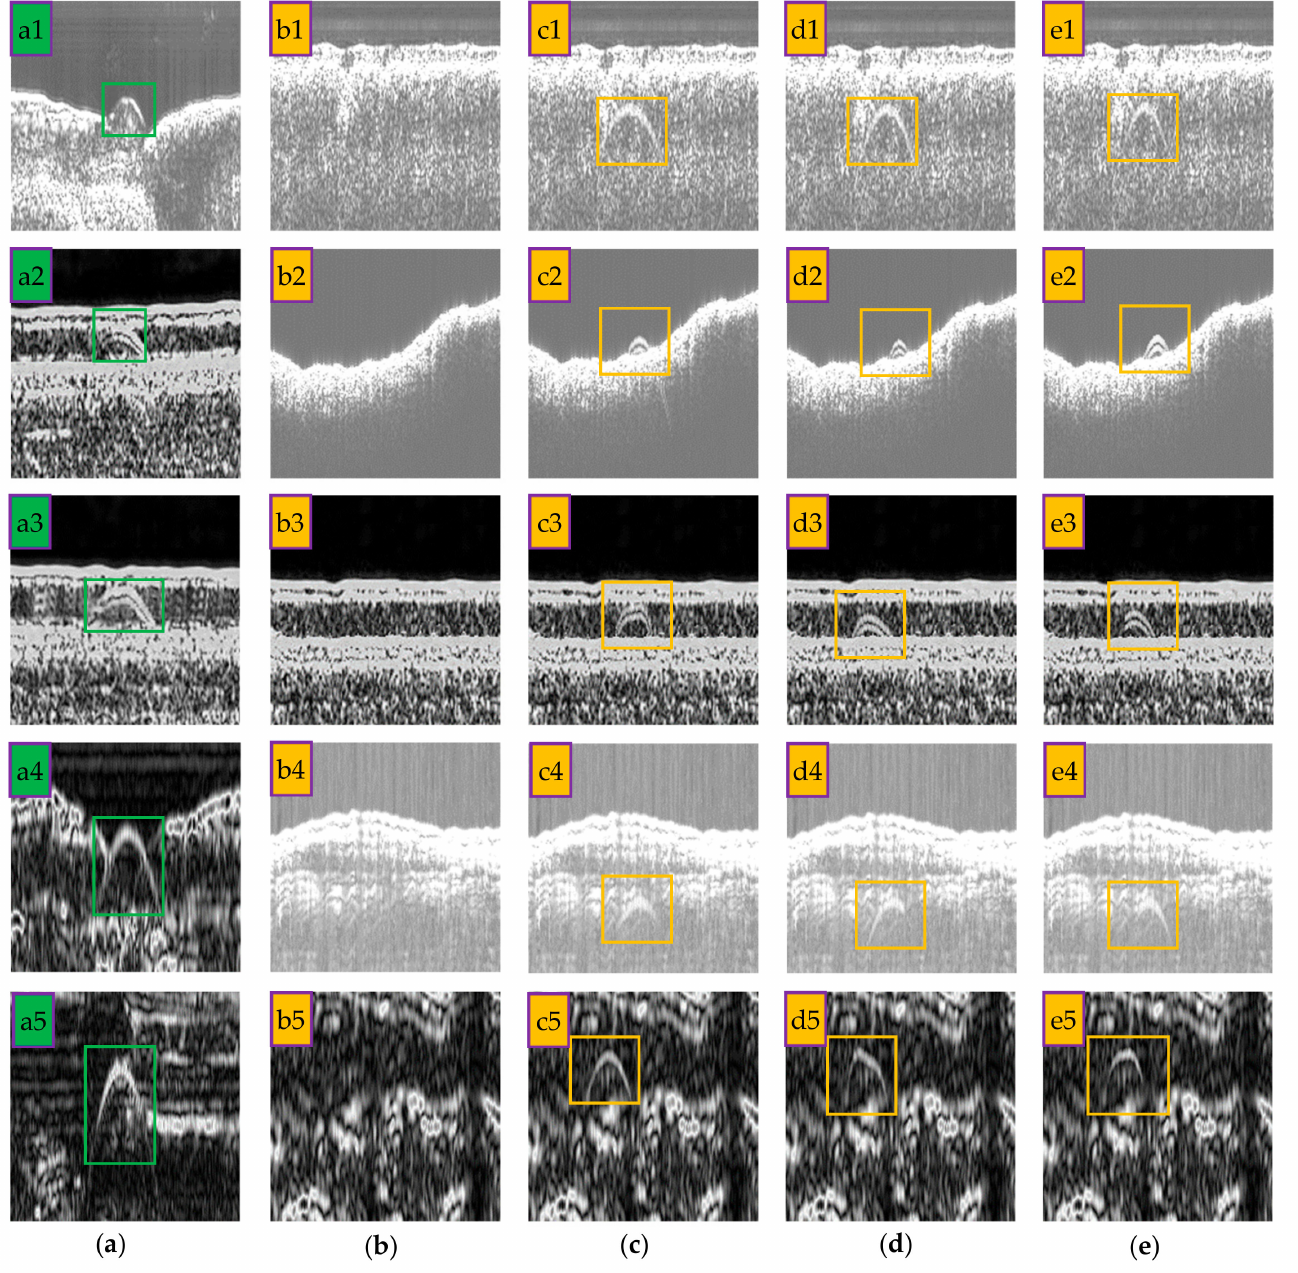
Figure 19. Sample synthesis results with the proposed method. ( a ) Measured pipeline images; ( b ) measured SBP images without pipeline targets; ( c – e ) synthesized samples with different parameter